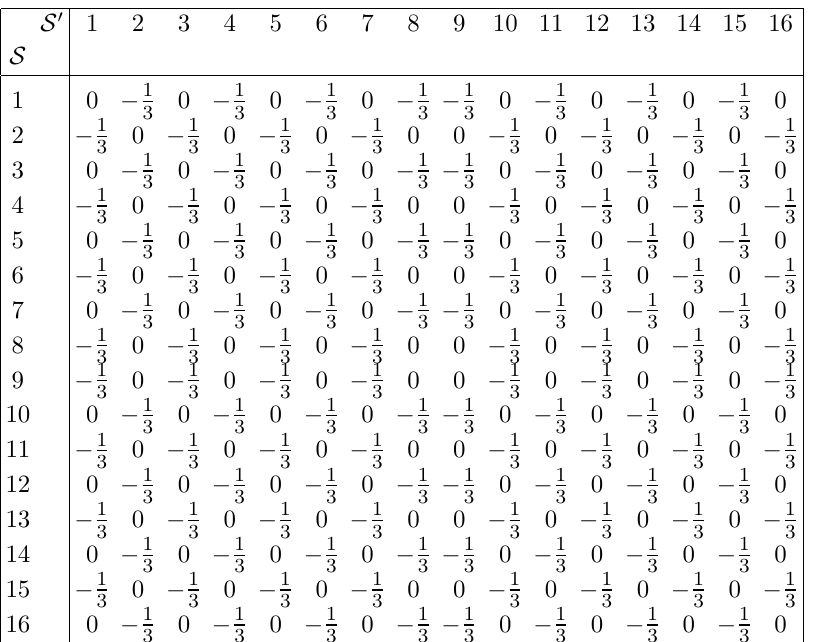
Table 19 . Gadget values for P